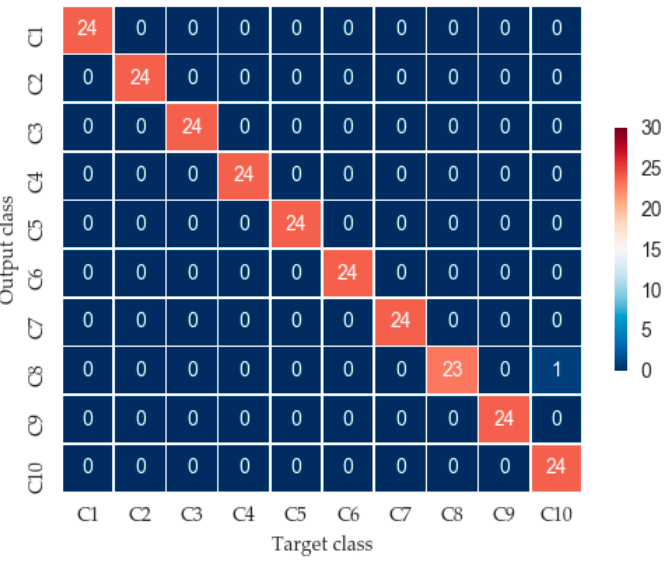
Figure 9. Confusion matrix of the simulation signal.